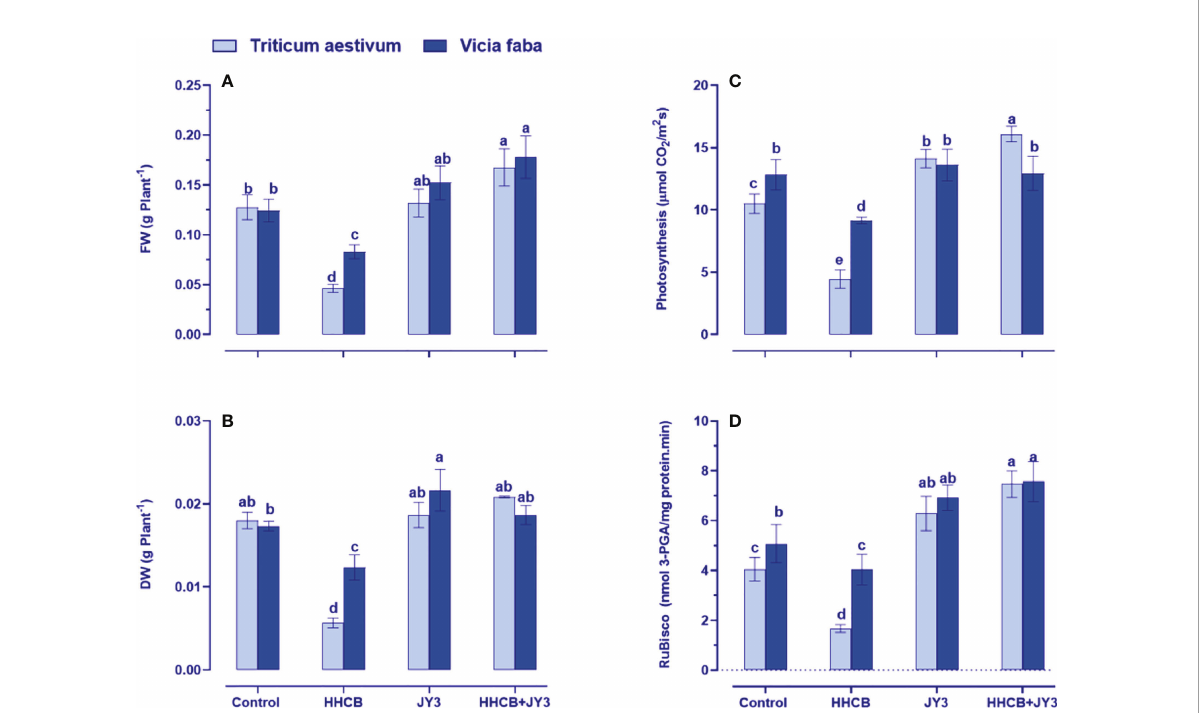
FIGURE 2 Effect of HHCB (hexahydro-hexamethyl cyclopentabenzopyran) either alone or in combination with Rhodospirillum sp. JY3 on (A) Fresh weight, (B) Dry weight, (C) photosynthesis, and (D) RuBisco activiy of both wheat and faba beans. Three biological replicates were used to detect each value. The bars on the columns represent error bars (SE). One-way ANOVA test was use to determine the signi fi cant difference between the groups. Similar letters on the bars indicate no signi fi cant difference between treatments. Fresh weight (FW), dry weight (DW), ribulose-1,5- bisphosphate carboxylase-oxygnase